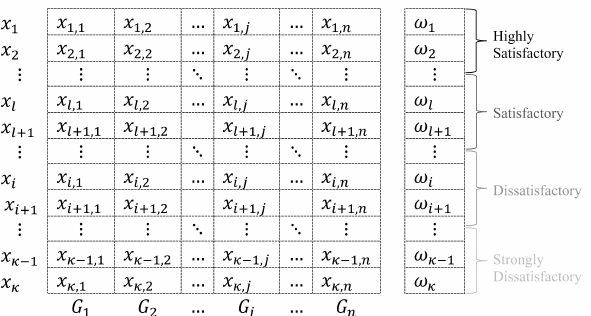
Figure 1. Pheromone matrix in